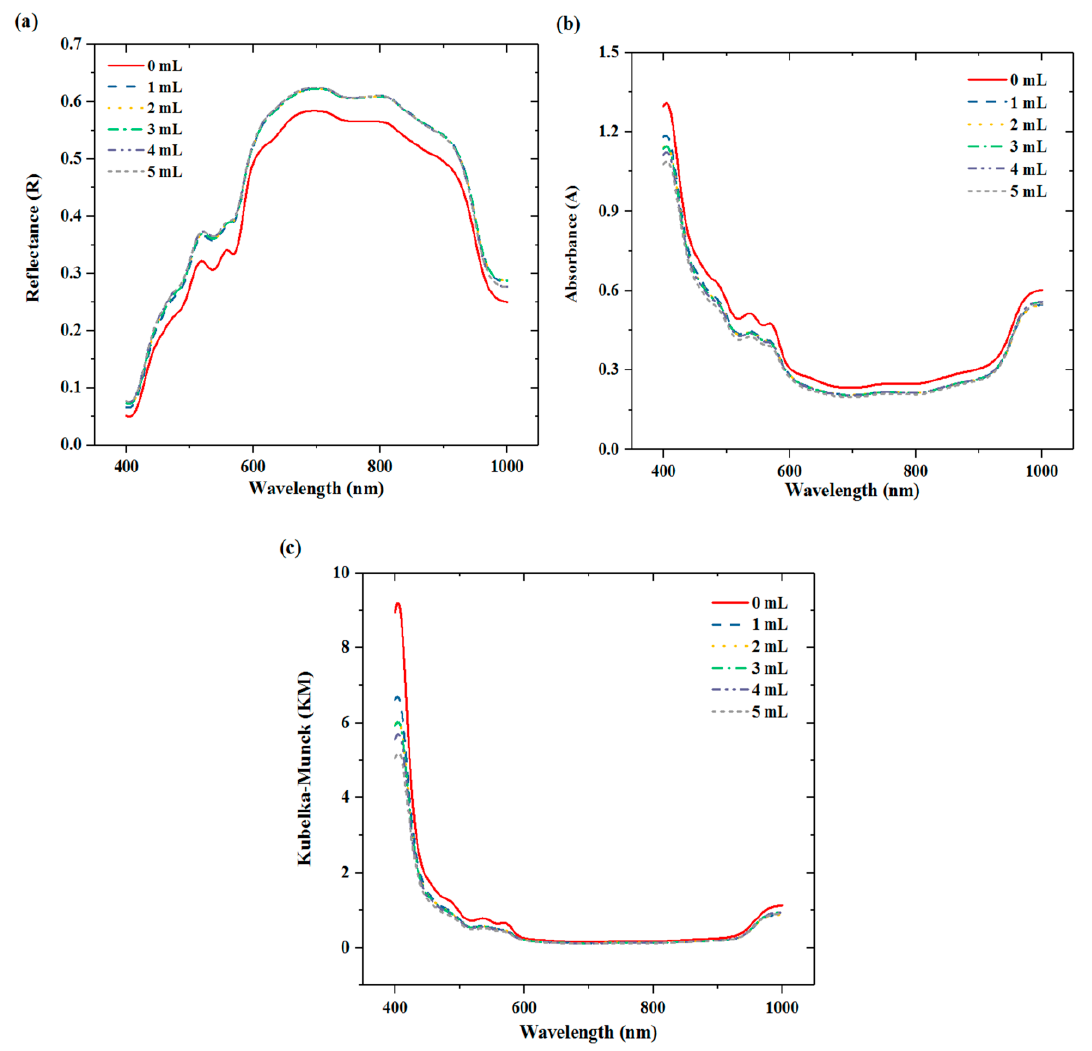
Figure 2. Average ( a ) reflectance (R), ( b ) absorbance (A), and ( c ) Kubelka-Munck(KM) spectra with different adulteration levels (0–5 mL). Table 1. Summary of partial least squares regression (PLSR) model results based on raw and preprocessed full R, A, and KM